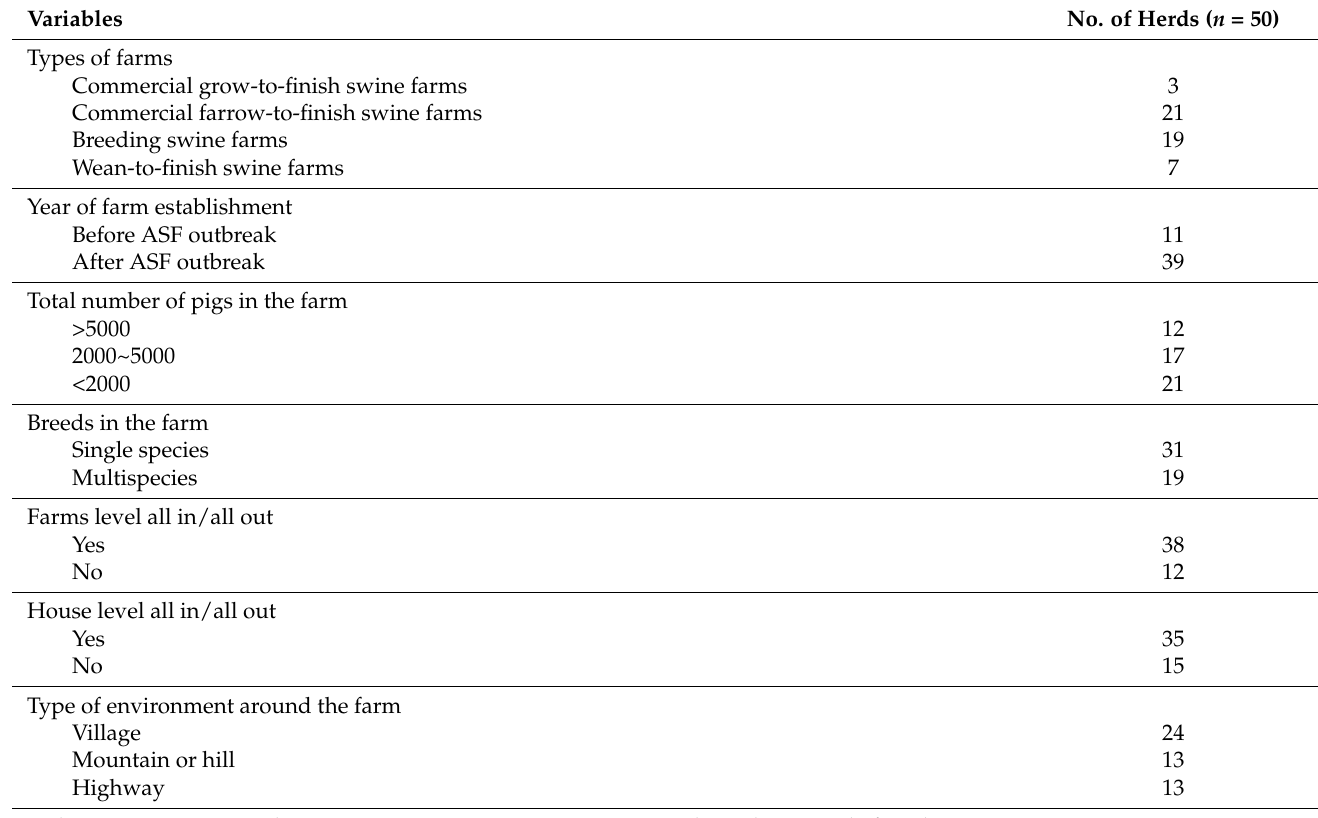
Table 1. Names, descriptions, and coding of the 19 variables and their categories included in the study as potential risk factors for viral diseases in the pig farms in